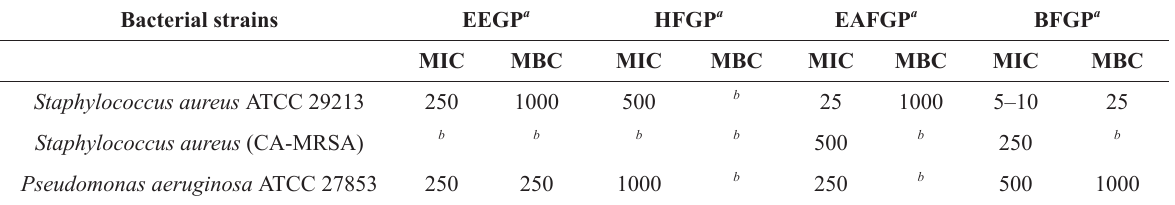
Minimum inhibitory concentration (mic) and minimum bactericidal concentration (mbc) values for the geopropolis ethanolic extract and its fractions.